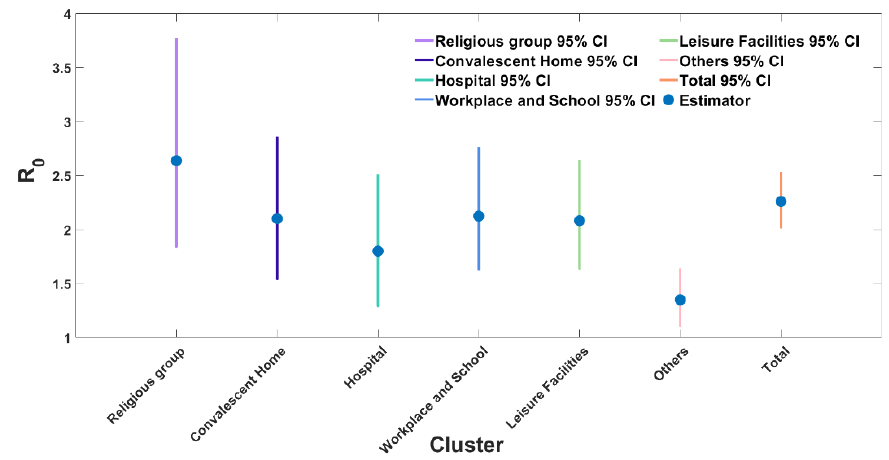
Figure 4. The effective reproduction number with 95% CI estimated by adjusting for the initial cases 𝑥 = 20 from 4 March to 4 December 2020. Table 2. Inference results for comparing the effective reproduction number and dispersion of clusters as initial case = 20 for COVID-19 in South Korea. Religious Convalescent Group Home